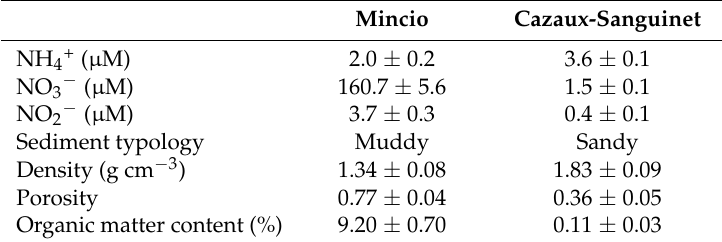
Table 1. Inorganic nitrogen concentrations measured in replicated water column samples ( n = 3) collected at the two investigated sites and sediment features ( n = 4) obtained by pooling the upper 10 cm sediment horizon. The reported values correspond to the average ± standard error.